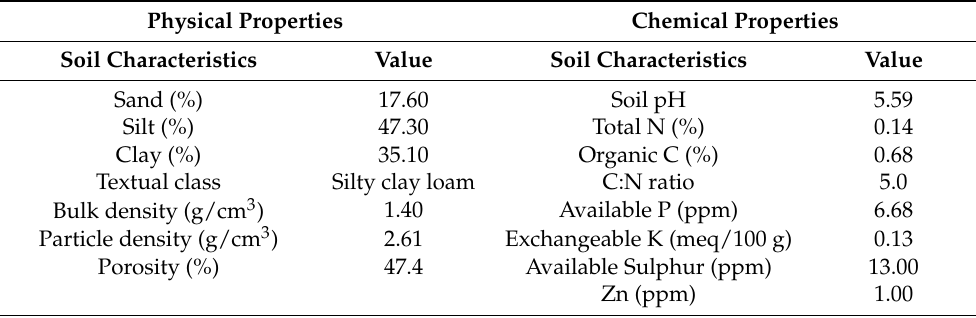
Table 2. Physico-chemical characterizations of the pot soil mixture used in the